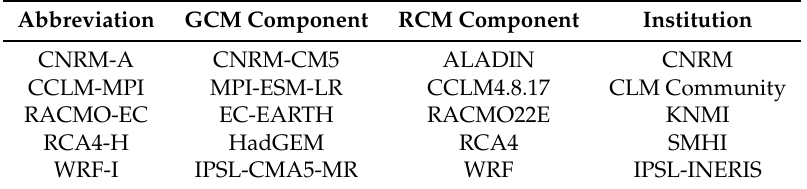
Table 1. List of GCM-RCM simulations selected for this study. The first column shows the abbreviation used in the text, the second and third columns show the GCM and RCM part of each model, respectively and the last column shows the name of the providing